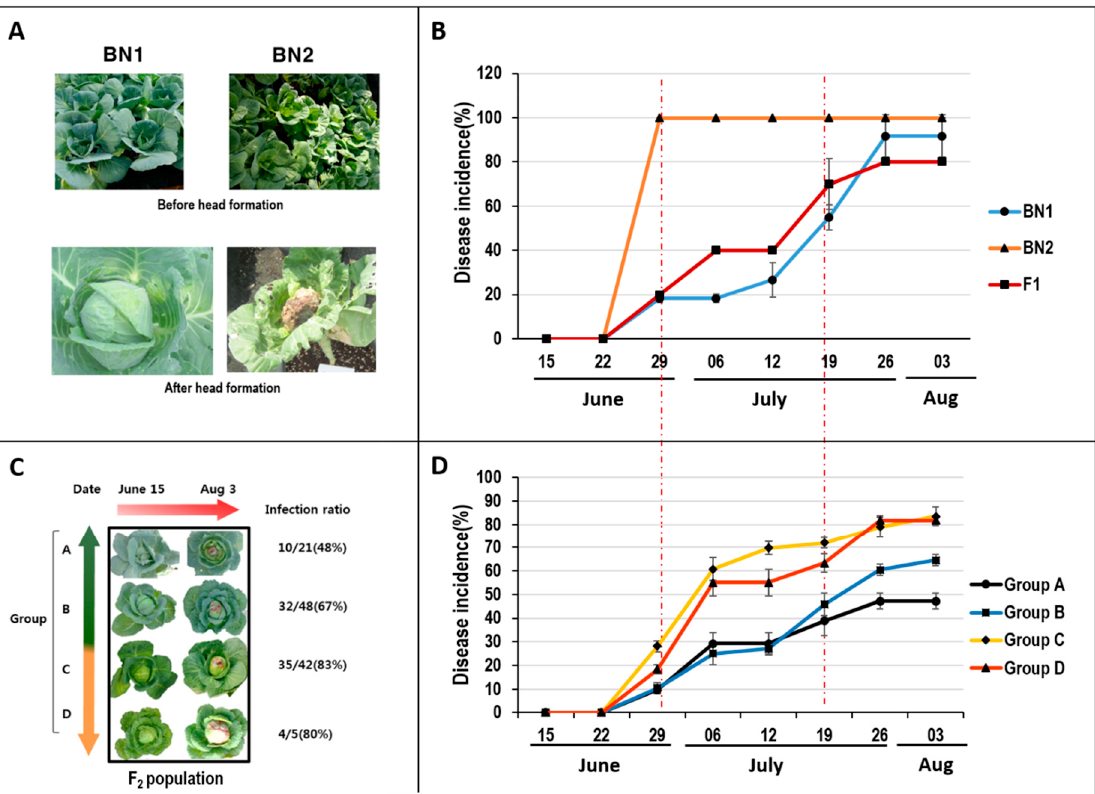
Figure 2. Morphology of soft rot incidence in plant materials used in this study. ( A ) Morphology of parental inbred lines before and after head formation, showing soft rot symptoms and leaf color (bluish green and deep green). ( B ) Soft rot incidence in parental lines and F 1 plants during the cultivation period. ( C ) Morphology of F 2 plants on the basis of leaf color and soft rot incidence. ( D ) Soft rot incidence in F 2 plants during the cultivation period. Vertical dotted lines between (B, D) indicate the period exhibiting the remarkable difference in soft rot incidence.